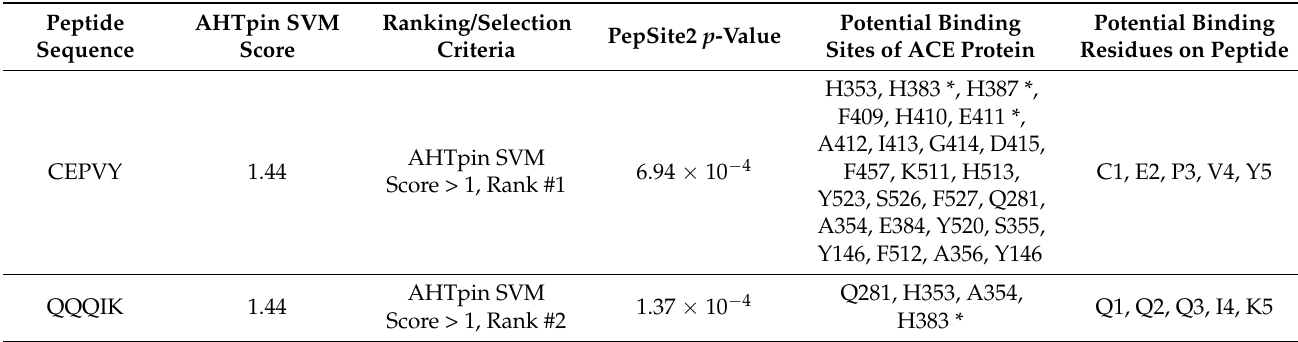
Table 4. PepSite2 analysis using ACE1 (PDB: 1O86) as the target